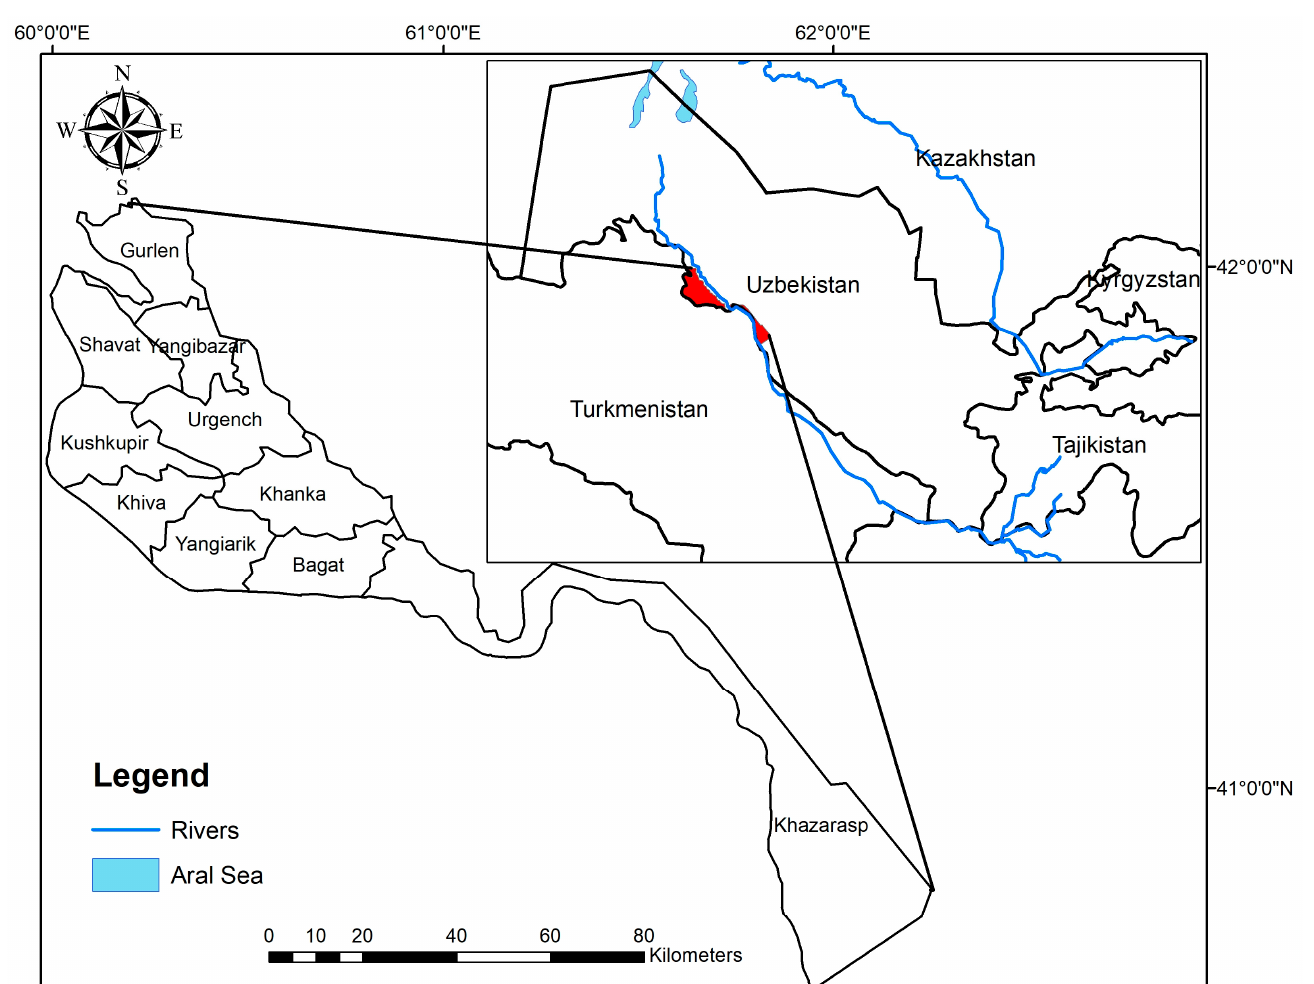
Figure 1. Location of the study region (own graph, generated using ArcGIS). Table 1. Physical and chemical properties of the soils in the Khorezm region, Uzbekistan. The region suffers from high levels of soil salinity, water shortage, energy inefficiency for pumping irrigation and low level of food production, which is a typical water-energy- food-environment (WEFE) nexus challenge. Since the Khorezm region’s irrigated lands are 100% saline, the samples were taken from three different districts with three different salinity levels: slightly saline areas in Khiva district, moderate saline areas in Kushkupir district, and high saline areas in Shavat district. Moreover, soil samples were taken from 20 points with 5 different depths (0–10, 10–20, 20–30, 30–60, 60–90 cm) from each area. Soil analyses were carried out in the laboratory of the Research Institute of Soil Science and Agrochemistry. The average values of the physical and chemical properties of the soils of the Khorezm region are given in Table 1. The physical and chemical properties of the soils are important factors that directly affect soil salinity. Salinity can also affect these properties by saline soil water, causing fine particles to bind together into aggregates. This is known as flocculation, which positively affects soil aggregation and stabilization through aeration and root growth; however, high salinity levels can have adverse and potentially lethal effects on plants [35]. In this process, soil texture plays a vital role in salinity, mainly through irrigation. It determines the amount of water stored or passing and the ability of salt to bind the soil. For instance, clay soils are slower to drain than coarse-textured soils due to their smaller particles blocking the spaces and preventing water percolation. In usual irrigation practices, sandy soils can flush more water through the root zone by larger particles than clay soils. Thus, sandy soils can handle irrigation with high-saline water by removing dissolved salt from the root zone